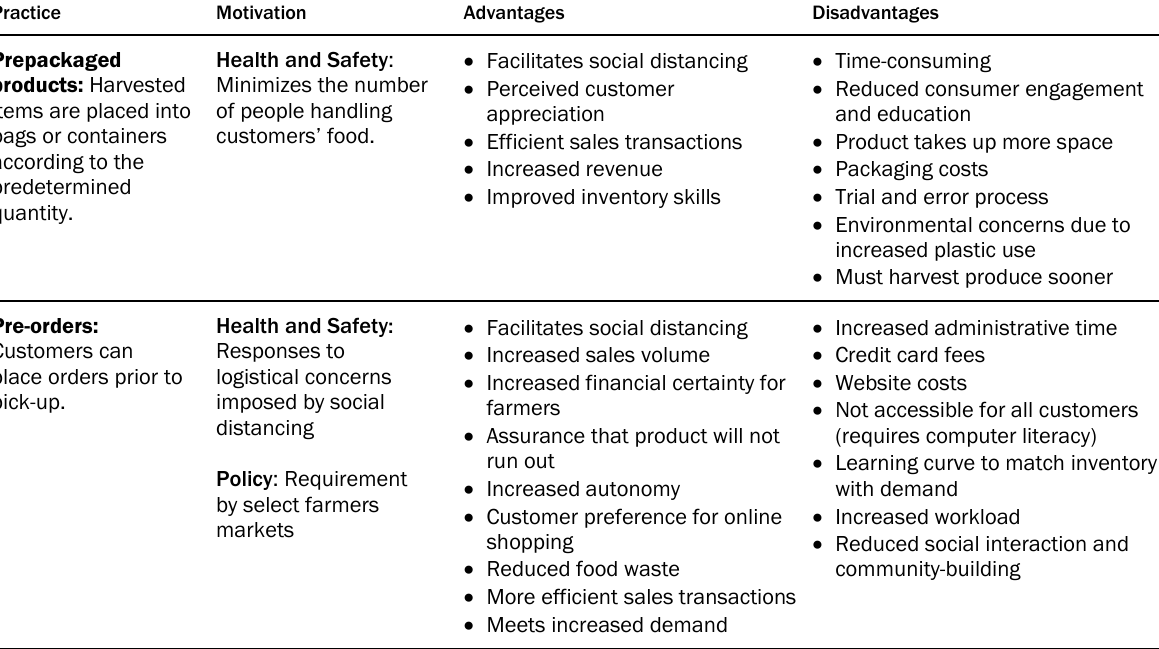
Table 2. Marketing Practices Newly Developed in Response to the COVID-19